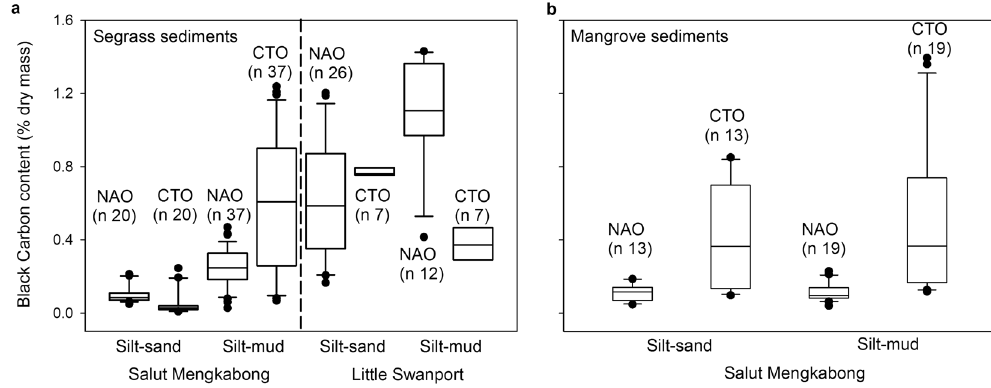
Figure 2. Black carbon content in seagrass and mangrove sediment cores from Salut–Mengkabong lagoon and Little Swanport estuary. ( a ) BC down seagrass sediment cores determined via chemothermal oxidation (CTO), which is thought to measure soots, and concentrated nitric acid oxidation (NAO), which is thought to measure both soots and chars. The results of the sediment analysis are separated into those for silt-sand and those for silt–mud, ostensibly within the upper and lower regions of the Salut–Mengkabong lagoon, a tropical tide- dominated system in a moderately urban environment, and Little Swanport estuary, a temperate tide-dominated estuary in a rural environment with a history of forest fires. The amount of organic carbon isolated via CTO within the upper silt–mud regions is on average greater than the amount isolated by NAO; this discrepancy suggests the existence of recalcitrant carbons other than BC (Mann-Whitney U = 14.0, P < 0.001). ( b ) The results of sediment analysis for the mangrove forests of Salut–Mengkabong show that amounts of organic carbon isolated via CTO continue to be significantly greater than the amount isolated via NAO across the whole lagoon (for silt-sand mangrove sediments, Mann-Whitney U = 22.0, P < 0.004; for silt-mud sediments, Mann- Whitney U = 32.0, P <